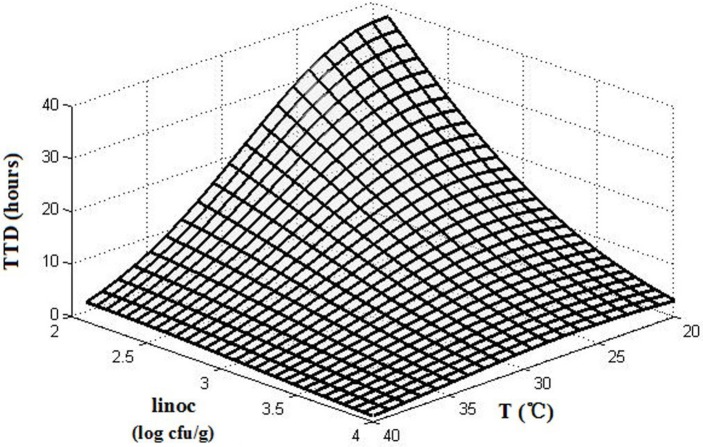
The 3D surface plots of TTD affected by temperature (T) and initial inoculation level (linoc).